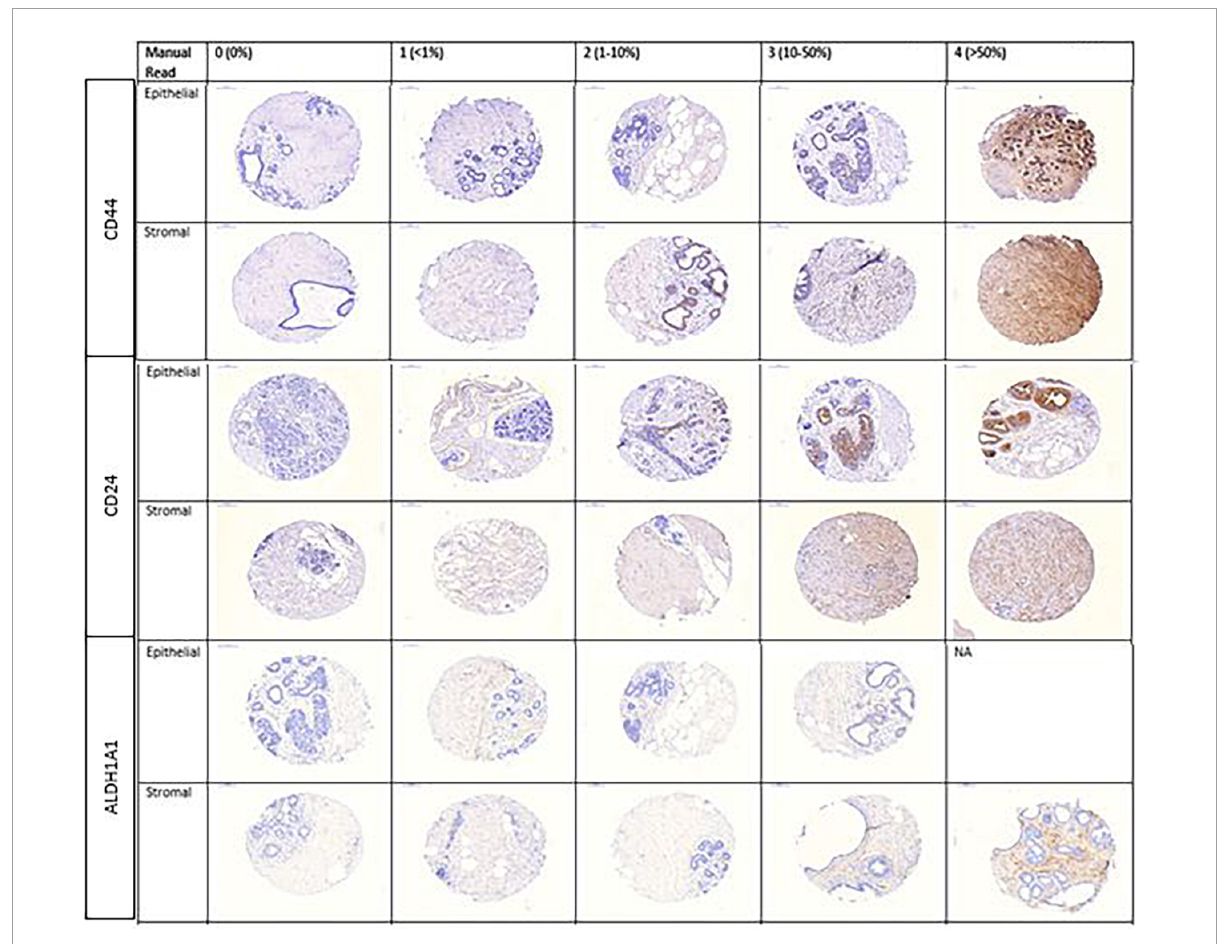
FIGURE2 Representative images of CD44, CD24, and ALDH1A1 markers by pathologist-assigned category.